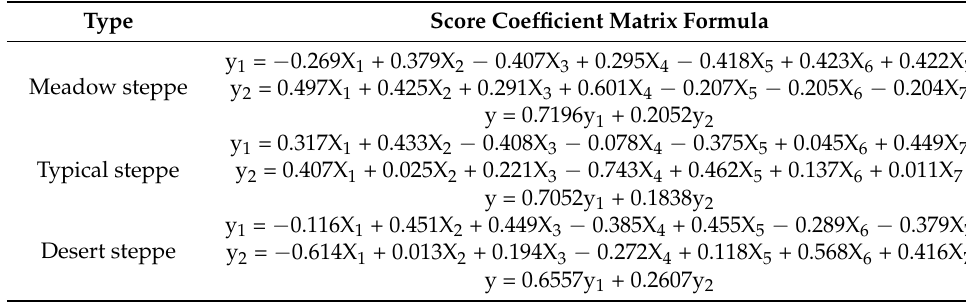
Figure 5. Principal component analysis of typical steppe. Table 4. Matrix formulas of soil quality score coefficients for different